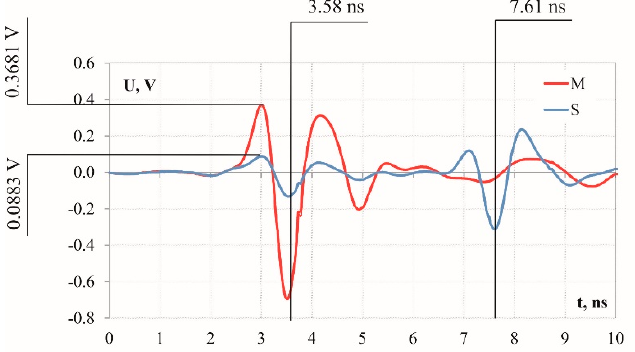
Figure A3. In the plot the two voltage signals correspond to: M – reflected by metallic sheet, and S – reflected by the sand box with buried metal sheet.